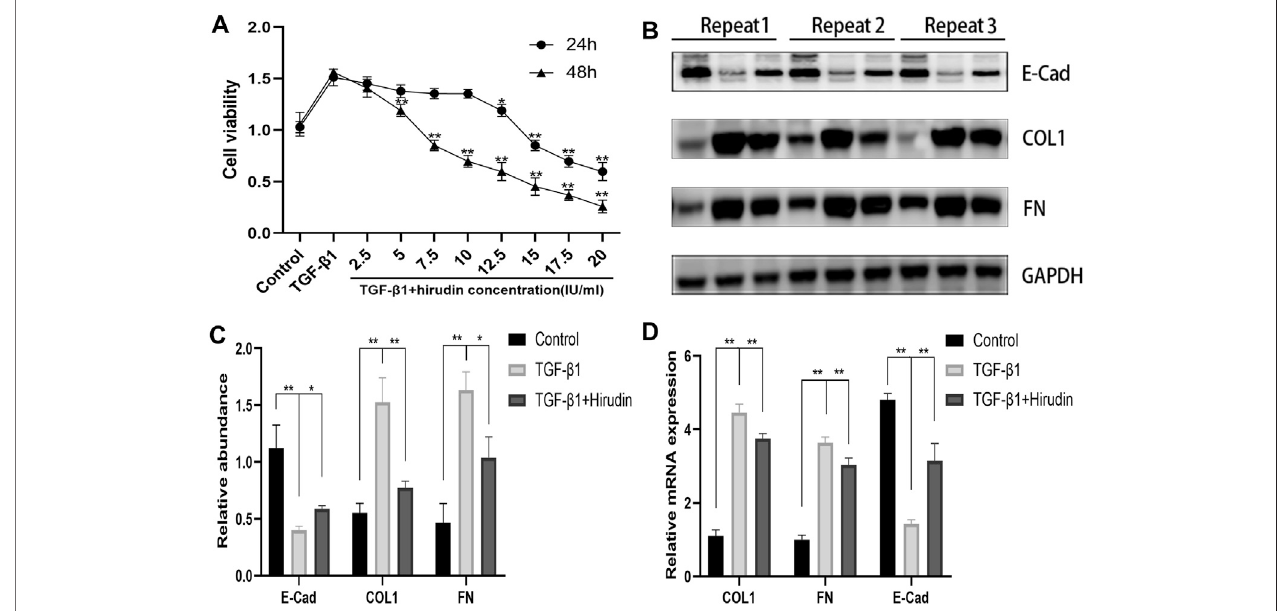
FIGURE 6 | Hirudin attenuates renal interstitial fi brosis in TGF- β 1 induced NRK-52Ecells. (A) CCK-8assay showed that the ability ofcell viability was decreased in NRK-52Ecellsbytreatmentwithhirudin. (B) EffectofhirudinonCOL1,FNandE-CadinNRK-52Ecells,asdeterminedbyWesternblot. (C) EffectofhirudinonCOL1,FN and E-Cad in NRK-52E cells, according to the results of Western blot. (D) Effect of hirudin on COL1, FN and E-Cad in NRK-52E cells, according to the results of RT- qPCR. Data are expressed as mean ± SD ( n (cid:2) 3 for each group). pp indicates p < 0.01 and p indicates p < 0.05.